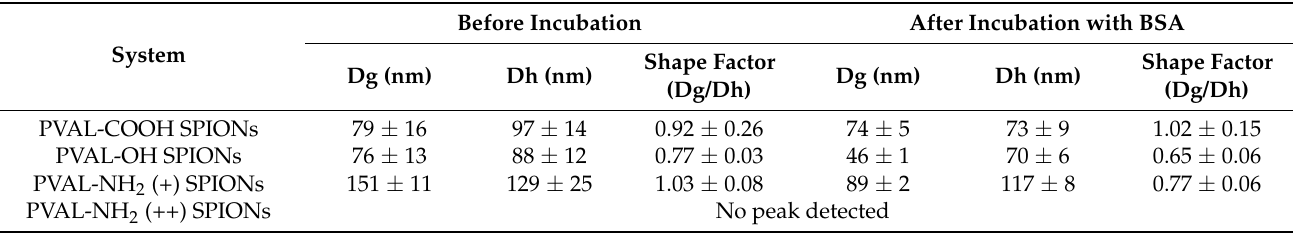
Table 5. Particle size obtained by MALS before and after incubation with BSA (Dg by the random coil model) and online DLS (Dh by a cumulant analysis). All values are averaged from 3 different